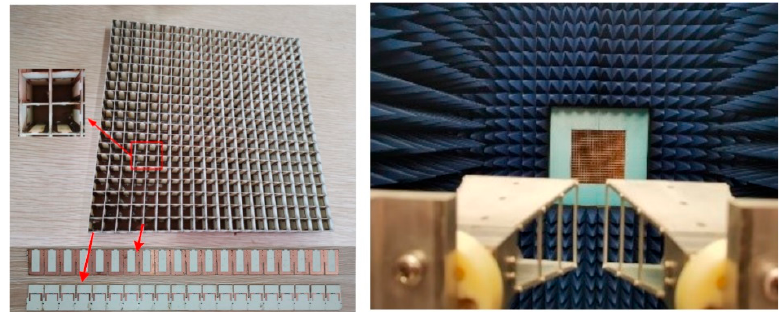
Figure 8. Photograph of the fabricated prototype and the measurement set-up.